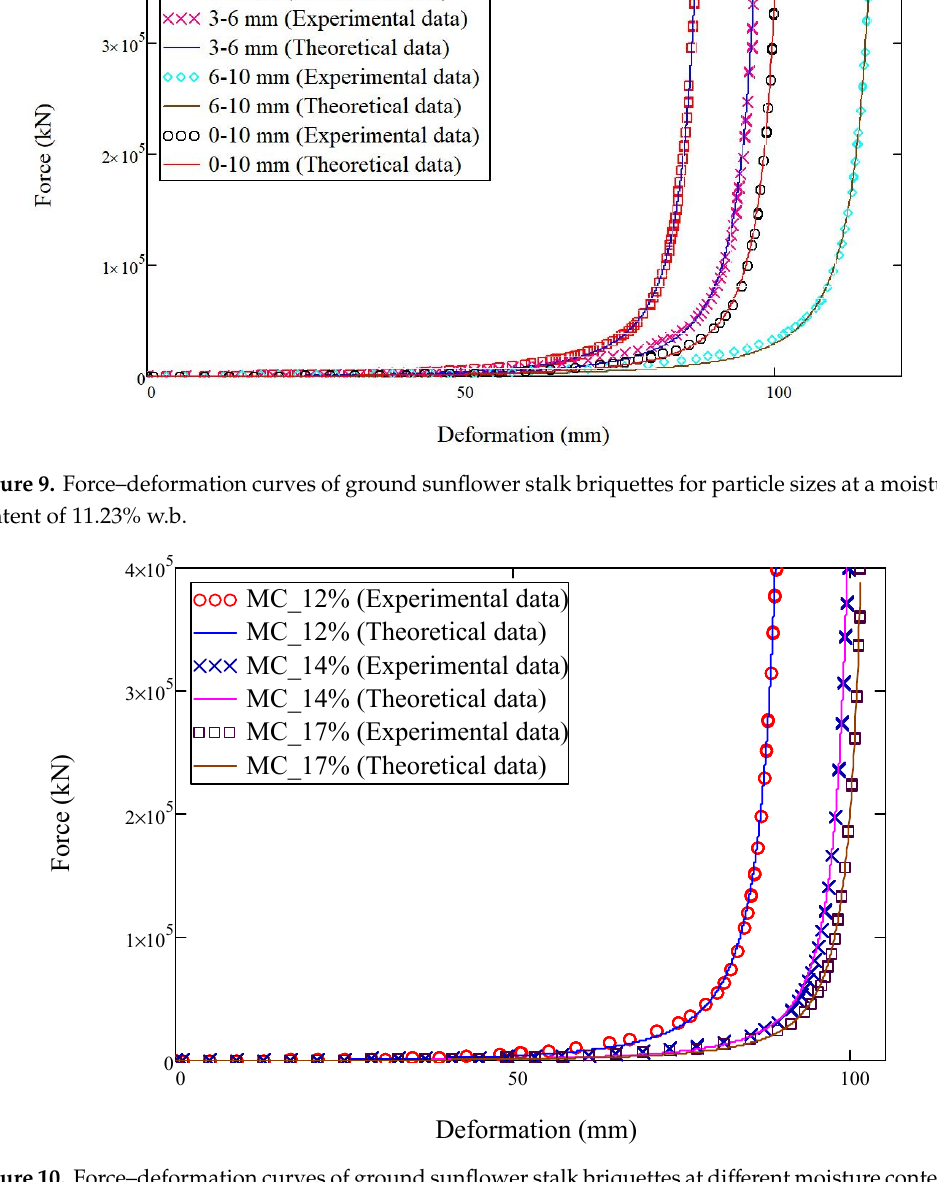
Figure 10. Force–deformation curves of ground sunflower stalk briquettes at different moisture contents for the particle size of 0 (0–10) mm.